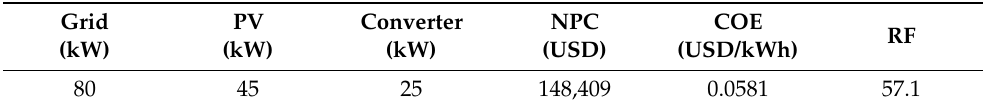
Table 6. Financial features of the optimized grid/PV